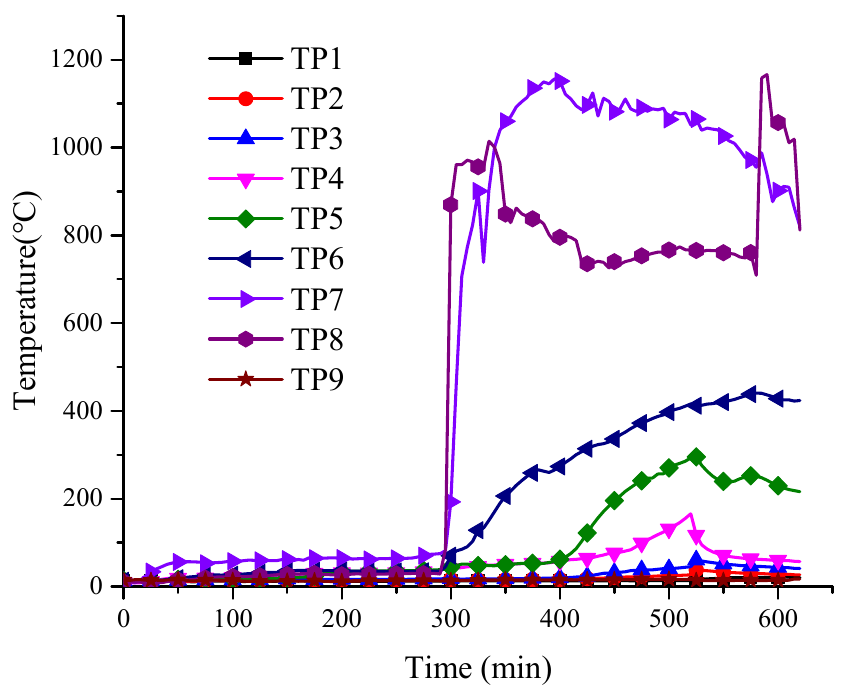
Figure 10. Temperature variation curves at different positions in horizontal direction (Path B close to bottom).